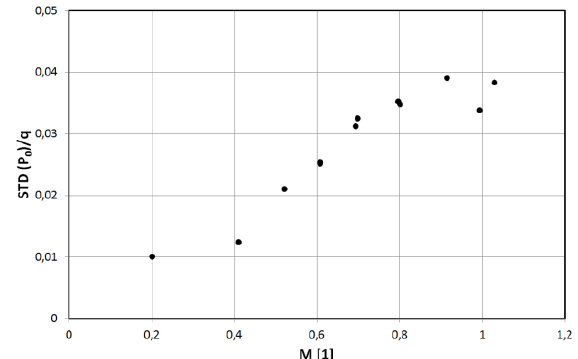
Fig. 9. Distribution of Mach number in the centerline of transonic slotted nozzle.